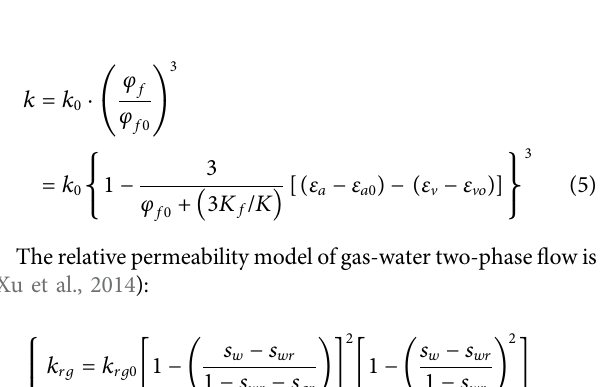
FIGURE 1 | Physical model of coal mass: (A) actual coal surface, (B) coal structure model, and (C) representative element volume (REV).